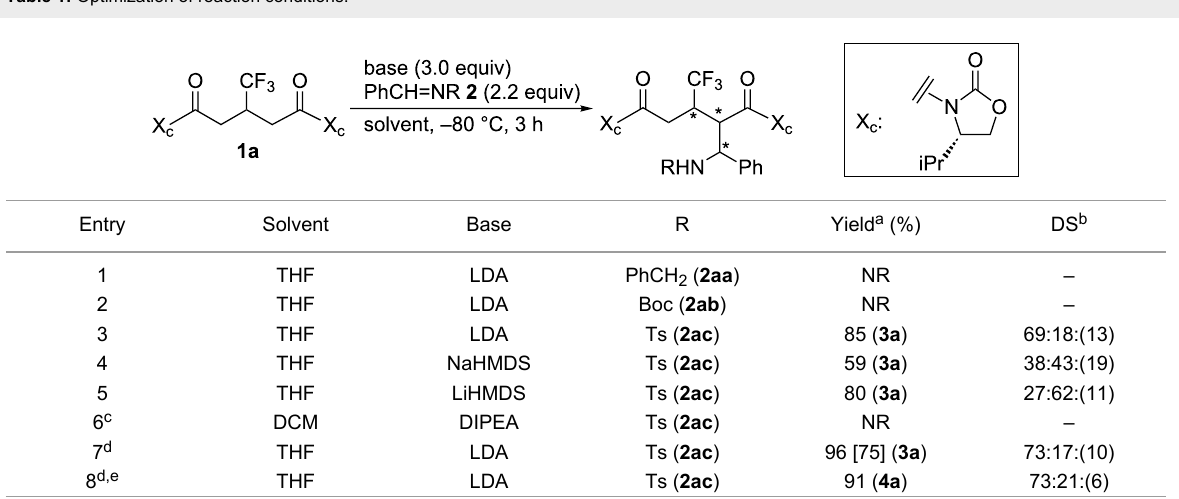
Table 1: Optimization of reaction